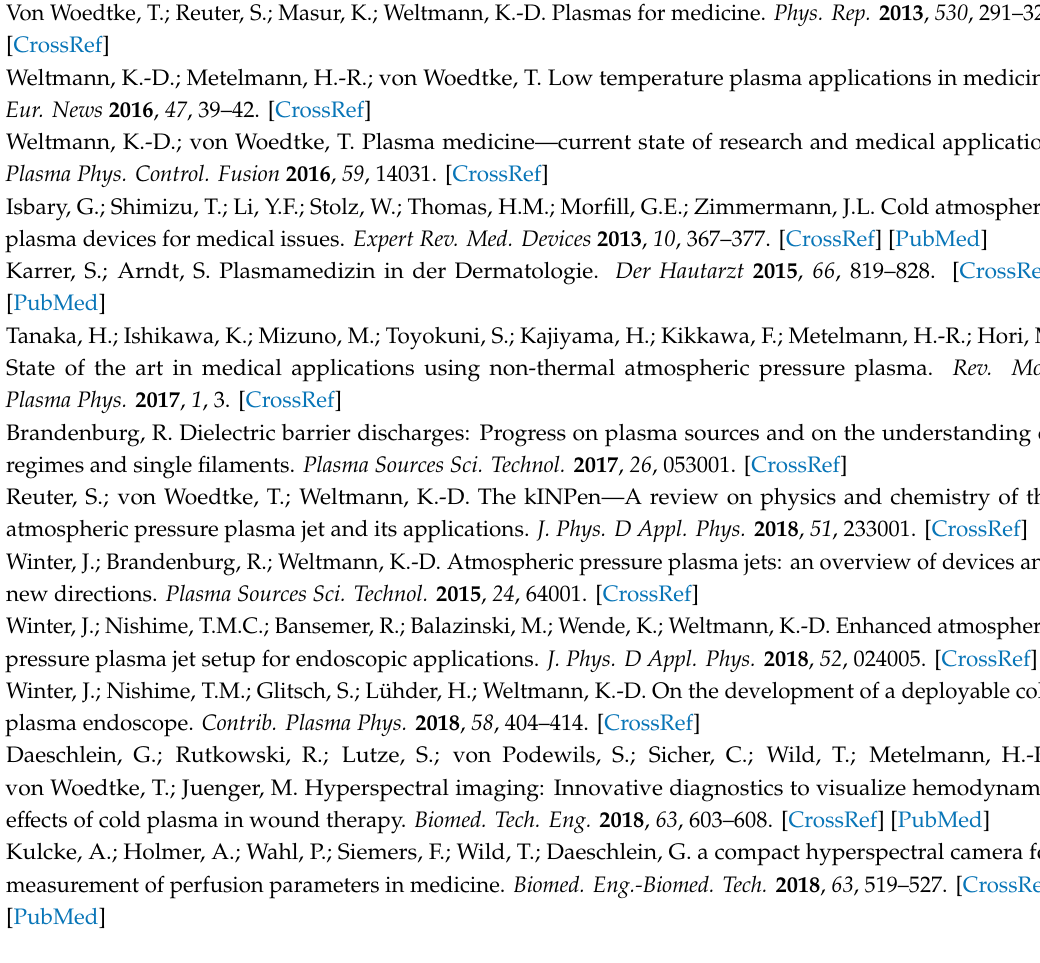
Figure S1: Multimodal nonlinear image of human skin tissue sample of TPEF (a), CARS (b) and SHG (c) before (upper row) and after CAP treatment (d–f) using the kINPen plasma device for 10 s with an Ar–oxygen working gas mixture. No morphologic changes were observed apart from an increase in autofluorescence. Figure S2: Multimodal nonlinear image of human skin tissue sample of 2P-FLIM (a), TPEF (b), CARS (c) and SHG (d) before (upper row) and after CAP treatment (lower row, same color code) using the endoscopic plasma device for 60 s with Ne working gas. Within the CARS and SHG channel, no morphologic changes have been observed apart from a significant increase in autofluorescence within the basal cell layer, which also leaks into the CARS image (550